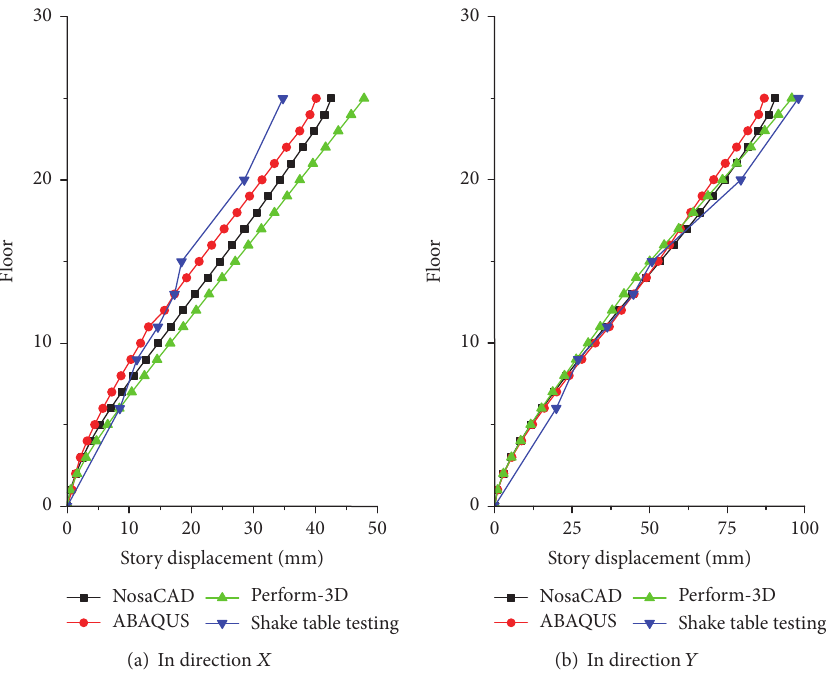
Figure 17: Story displacement envelopes under frequent intensity 7 earthquakes.